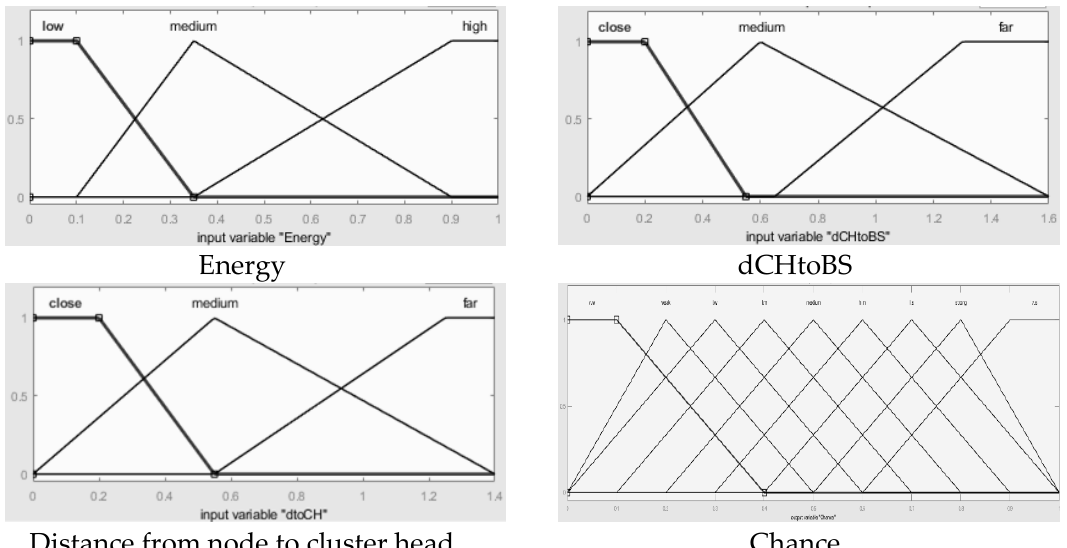
Figure 9. Membership functions of inputs and output in second FIS. Table 3. FIS input and output variables during cluster formation.